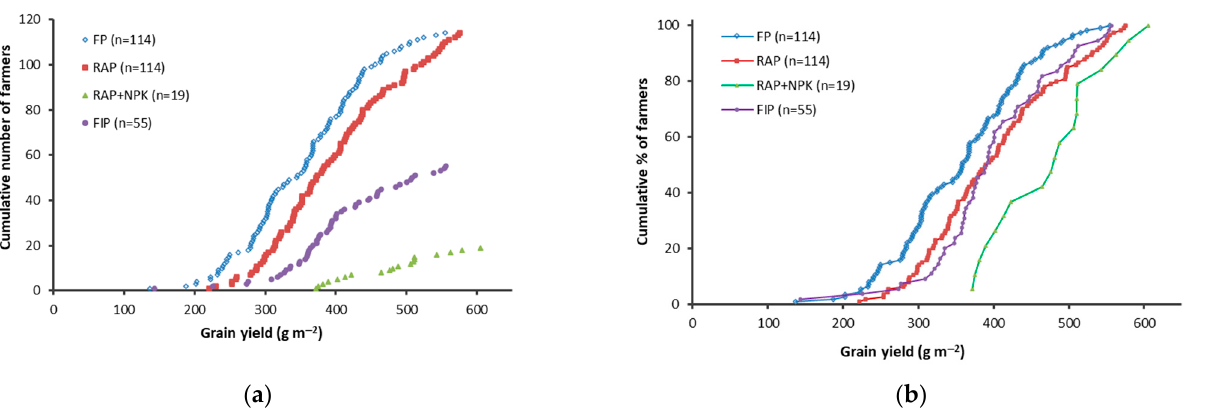
Figure 1. Cumulative frequency diagrams of yields obtained under different management levels: farmers’ practice (FP), recommended agronomic practices without fertilization (RAP), RAP plus NPK application (RAP+NPK) and farmers’ intensification practice (FIP). ( a ) is plotted as number of farmers and ( b ) as percentage of farmer population.